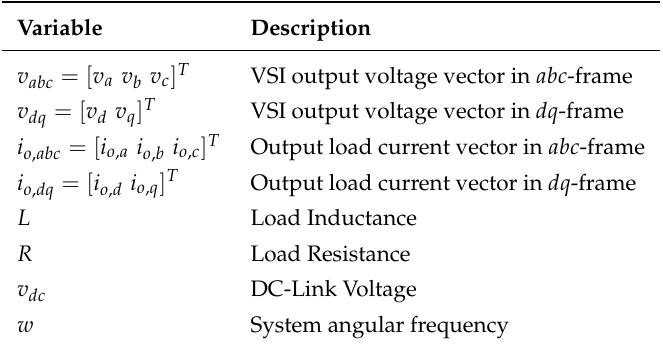
Figure 1. Three-phase two-level inverter with RL (resistive-inductive) load diagram. Table 1. System variables and